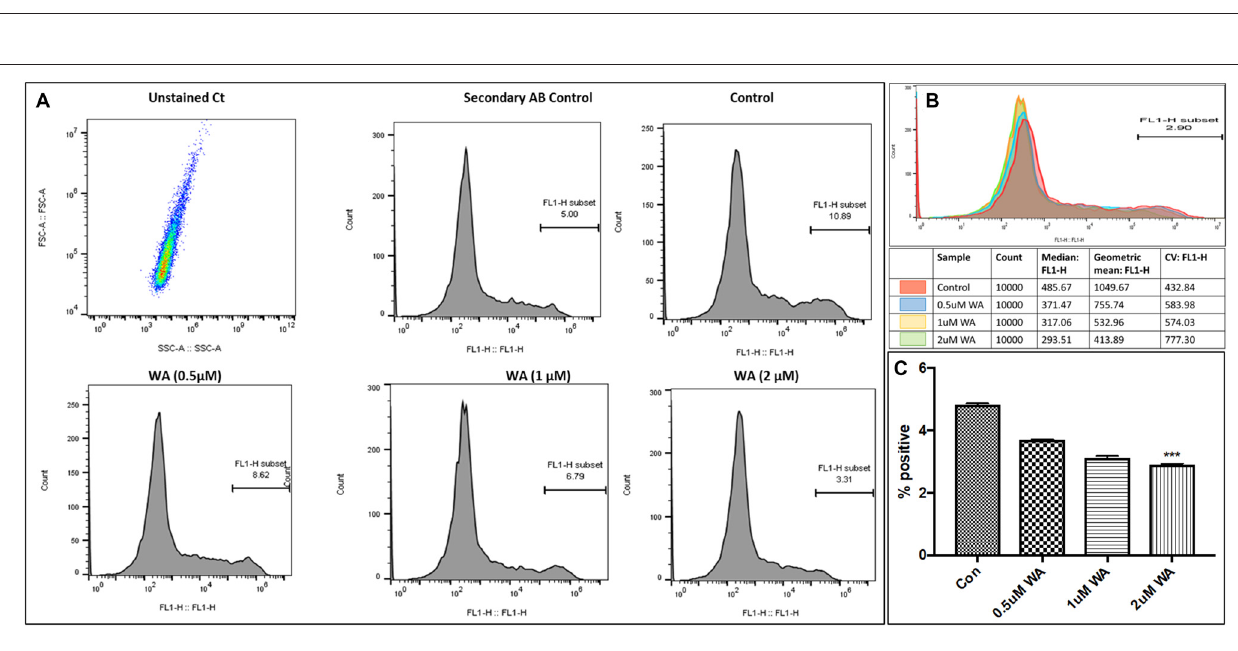
Tat protein/coc +/ − WA. After 48 h, the supernatant was discarded and the cells were fixed in 4% PFA. PFA embedded slides were then washed and immunostained using MAP2 primary antibody (1:100) and anti-FITC secondary